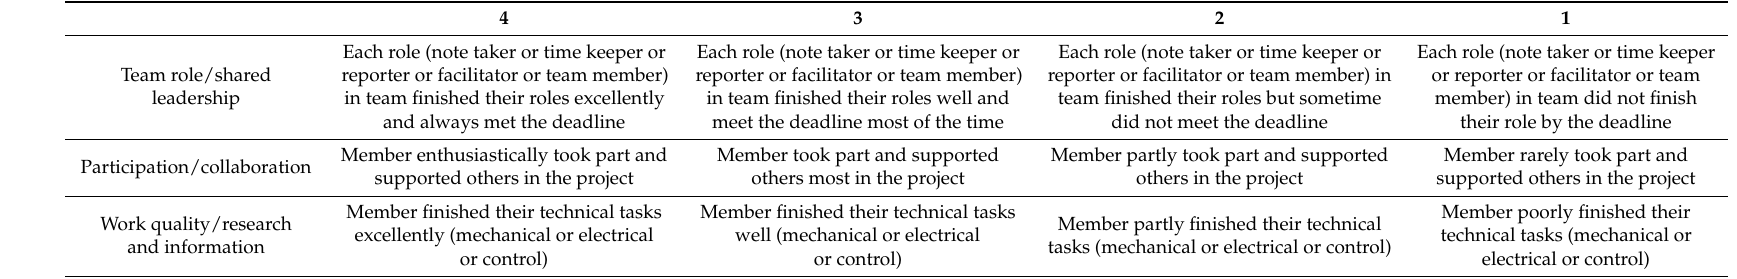
Table A3. Evaluations of Team